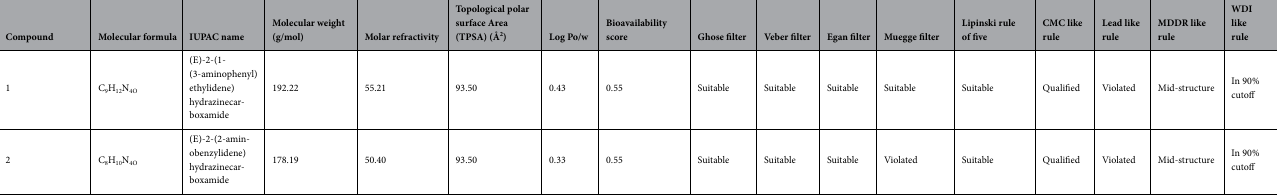
Table 3. The drug likeliness features of the selected compounds predicted by PreADMET and